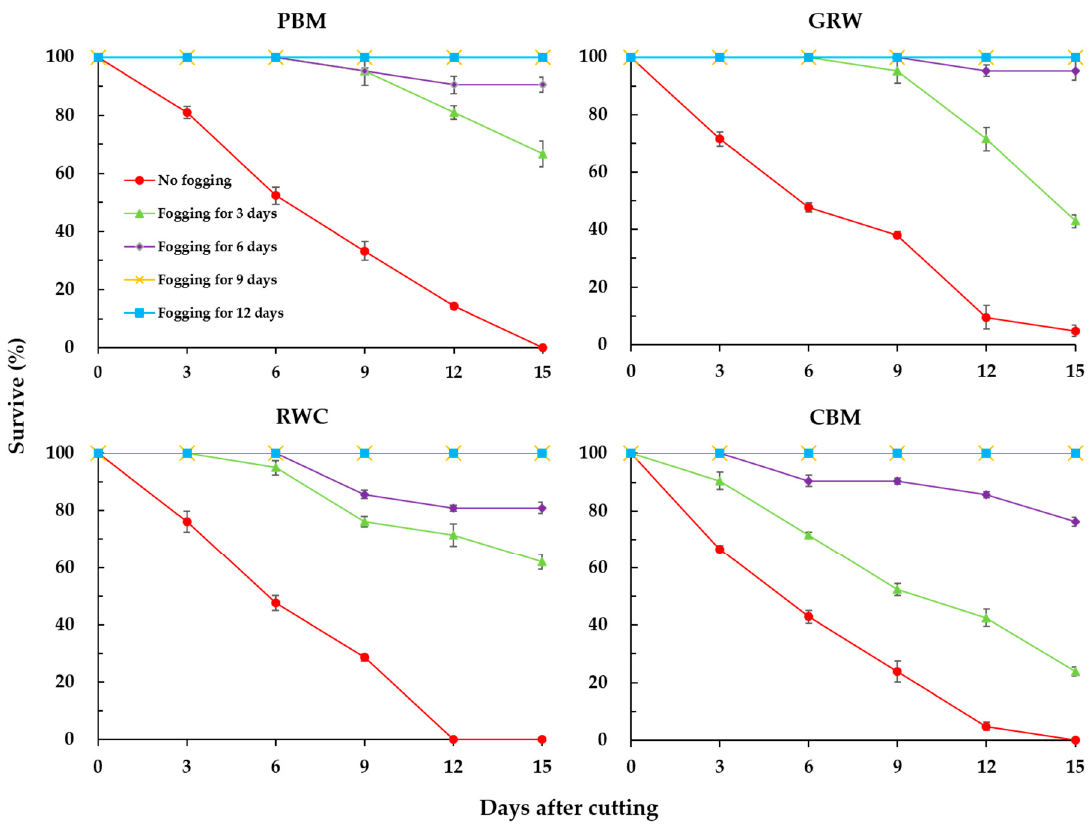
Figure 4. The effects of the growth medium on the survival percentage of daughter plants of strawberry ‘Maehyang’ with 0, 3, 6, 9 and 12 days fogging treatments. Error bars represent the SEs of the three observation units ( n = 3). PBM, a peat moss-based mixture; RWC, rockwool cube; GRW, granular rockwool; and CBM, a coir-based mixture.